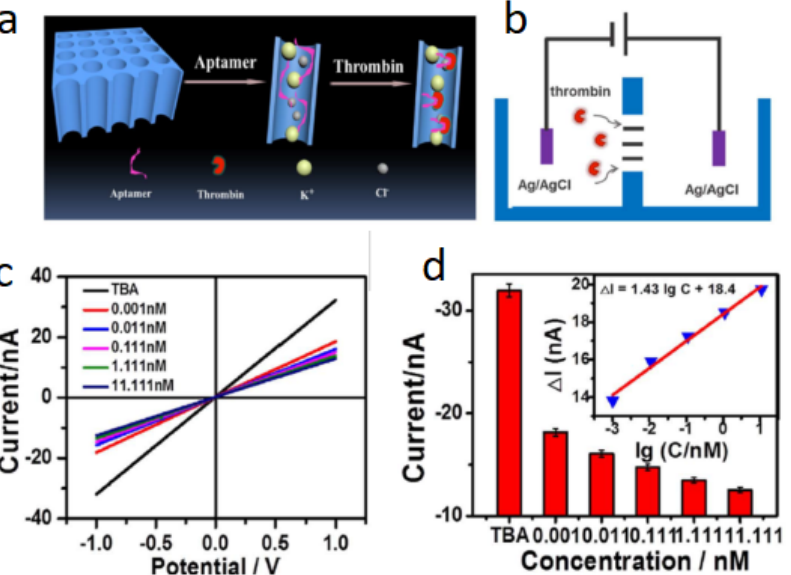
Figure 7. Nanochannel-based electrochemical aptasensor. ( a ) Thrombin immobilized within nanochannels, ( b ) counter-counter design of the aptasensor, ( c ) the I–V profiles obtained with different concentrations of thrombin, and ( d ) the ionic current versus thrombin concentration. Adapted from [97].